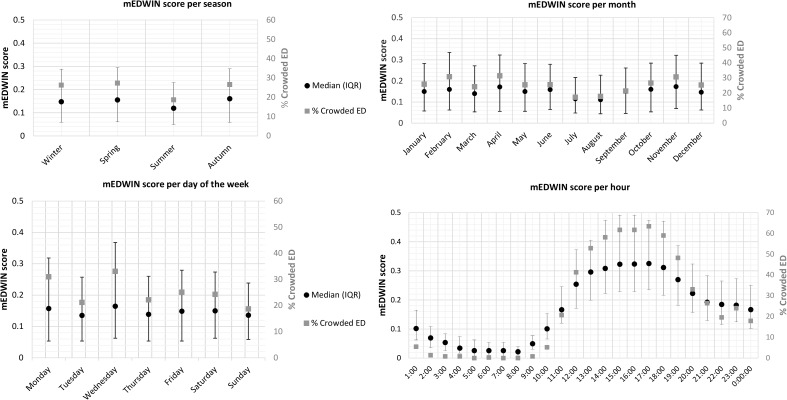
Median mEDWIN with corresponding interquartile range and percentage of ED crowding based on 75th percentile of the mEDWIN per season, month, day and hour.ED = Emergency Department; IQR = Interquartile range.